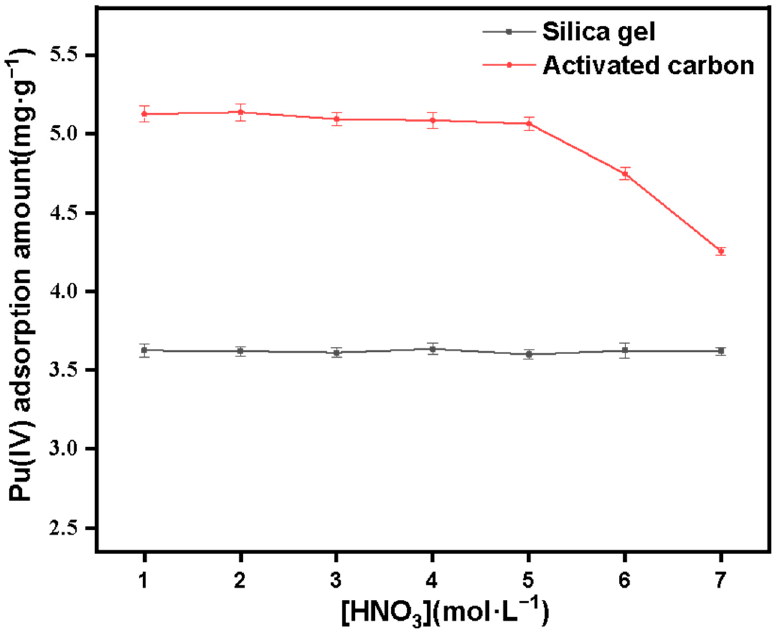
Figure 16. Effect of HNO 3 concentration on the adsorption of Pu(IV) on silica gel and activated car- bon.